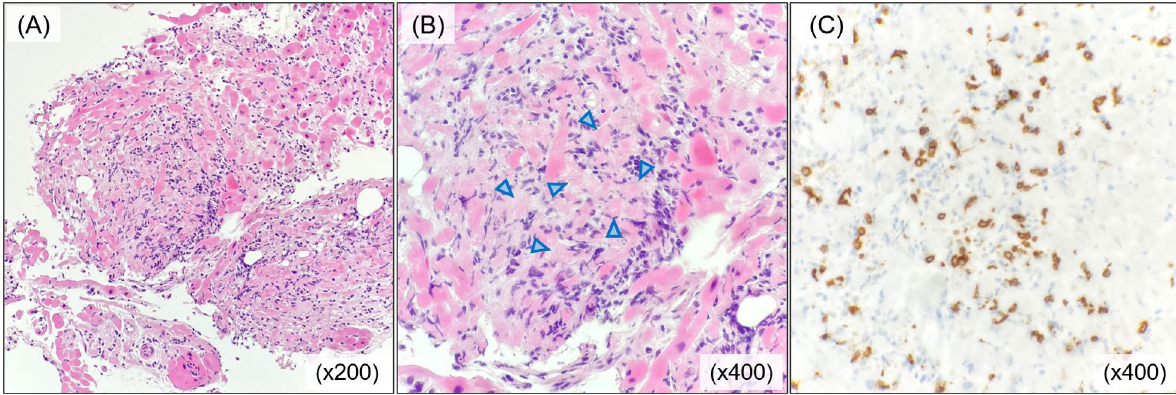
Fig. 2 Histological findings of myocardial biopsy. Histological findings of the myocardial biopsy are shown. A, B Myocardial tissue contains marked infiltration of lymphocytes, histiocytes and cardiomyocytes with degeneration and necrosis (blue arrowheads) evident (hematoxylin and eosin staining). C Marked infiltration of CD8-positive T cells was